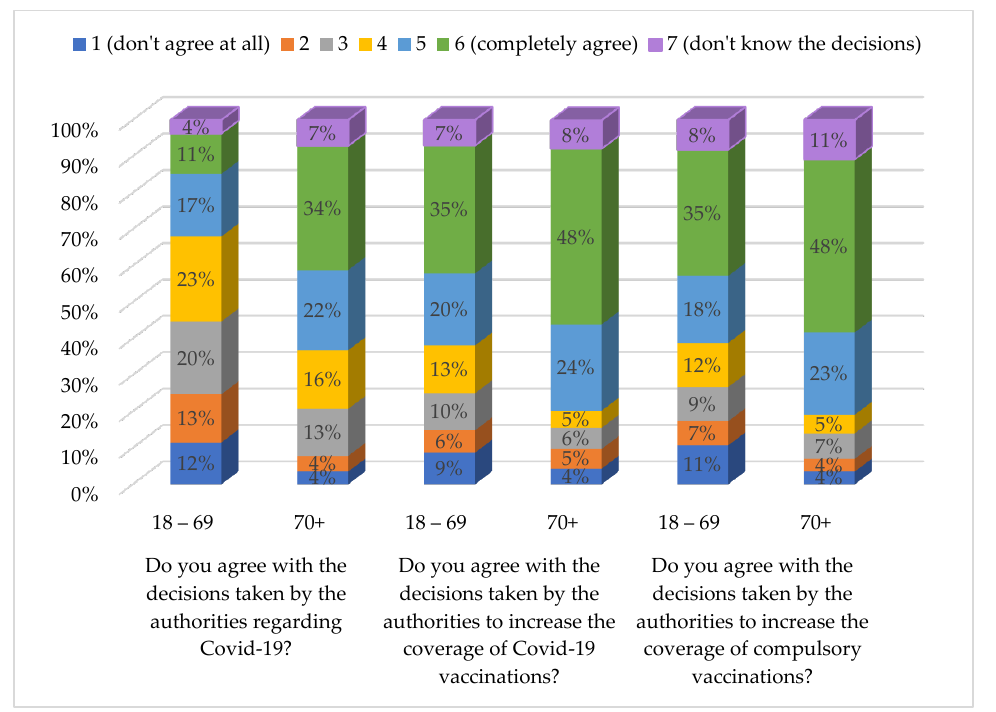
Figure 2. Responses to survey items regarding agreement with the decisions taken by the authorities